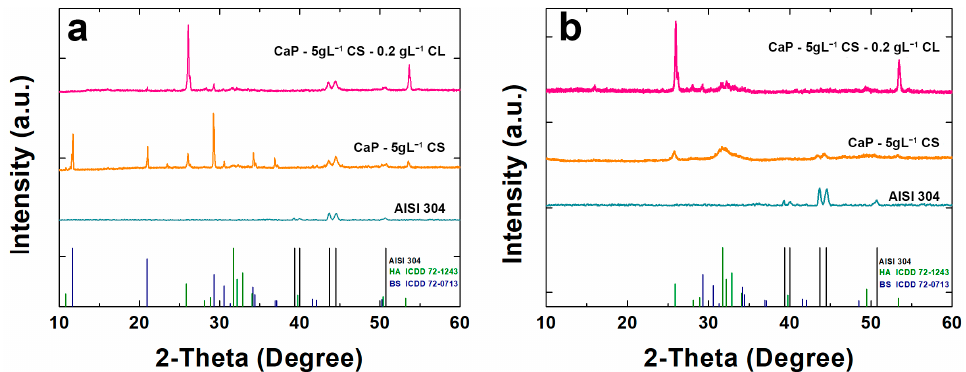
Figure 3. X-ray diffraction patterns of CaP/CS and CaP/CS/CL coatings: ( a ) before and ( b ) after aging in SBF. The pattern of uncoated AISI 304 was also reported for comparison.